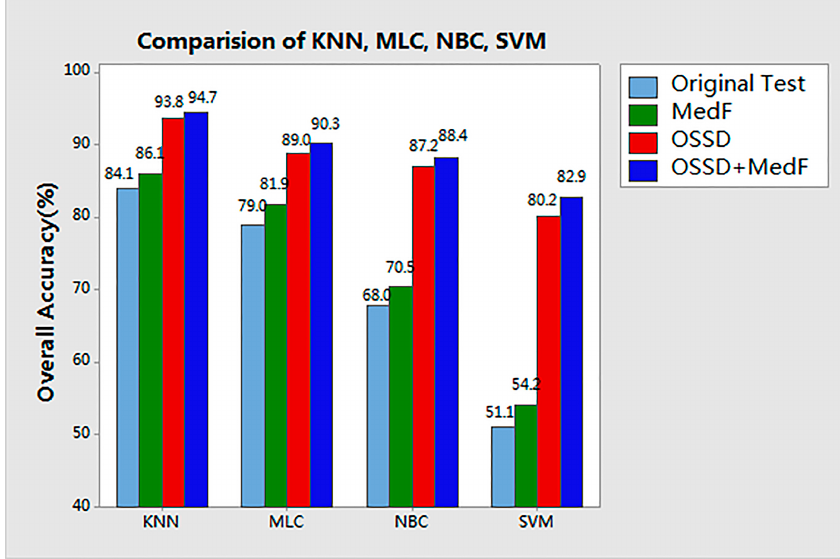
Figure 9. Aerial image accuracy comparisons of OA (%) based on different classification methods and supervised classifiers.